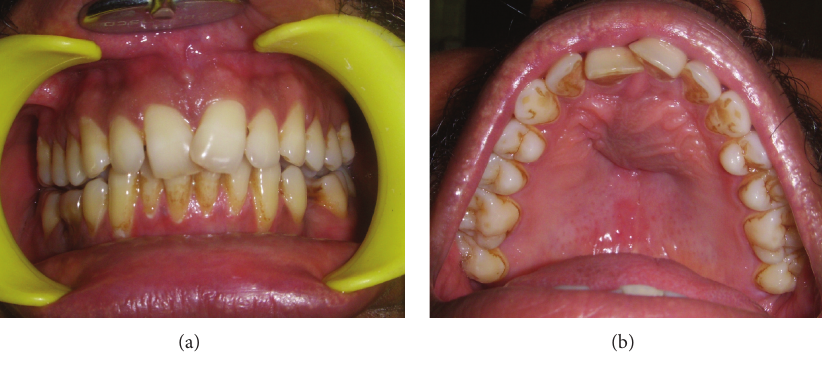
Figure 1: Preoperative intraoral swelling.